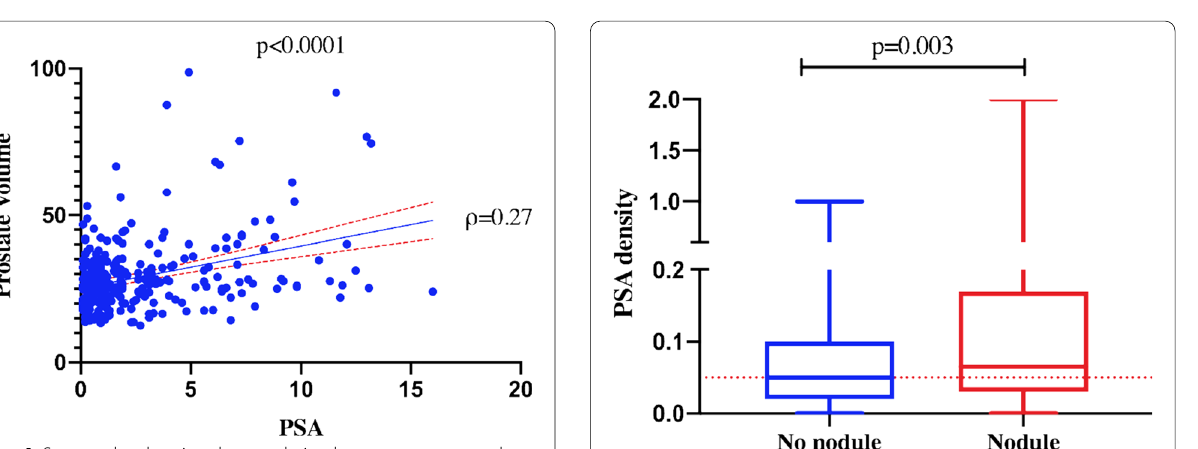
Fig. 4 Scatter plot showing the correlation between prostate volume and serum PSA levels